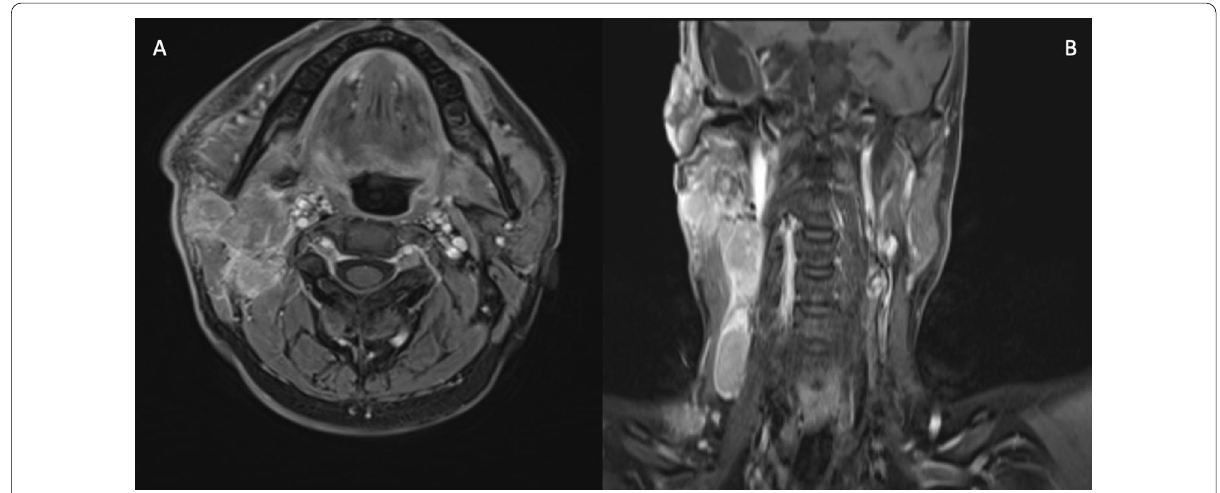
Fig. 5 Neck MRI scan ( A axial- B coronal sections)